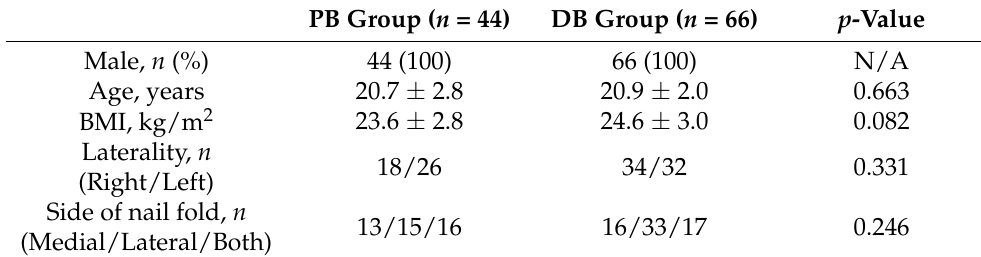
Table 1. Demographic characteristics of the study groups a